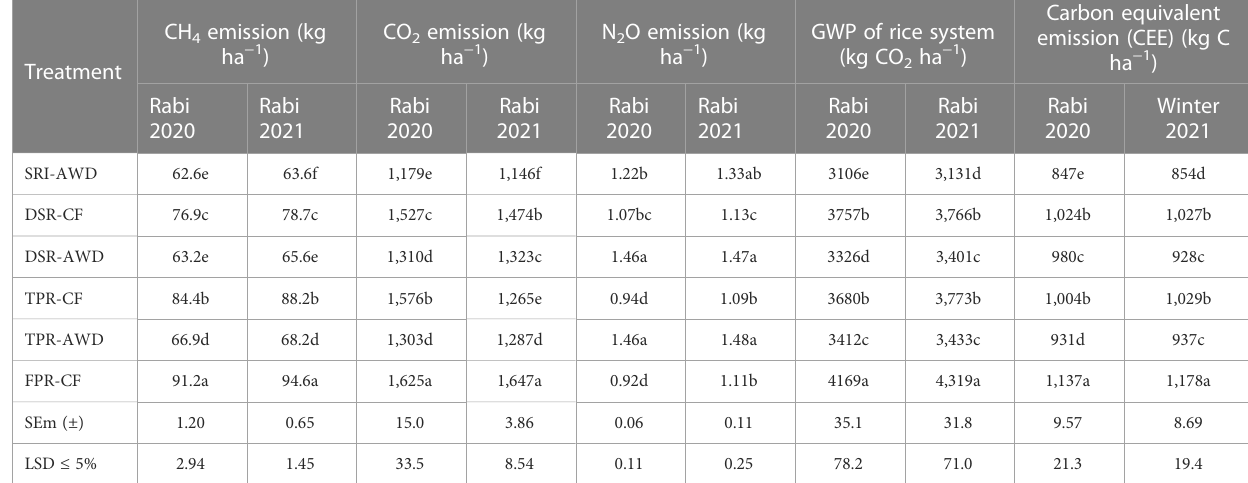
TABLE 5 Greenhouse gas emissions, GWP, and carbon equivalent emission in different rice production techniques.